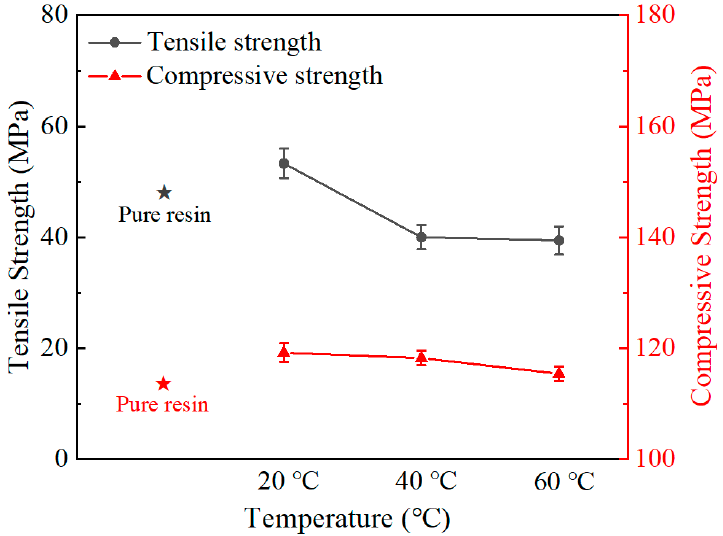
Figure 4. Tensile and Compressive strength of 10 vol.% fly ash/epoxy composite prepared at 20 °C, 40 °C, and 60 °C.